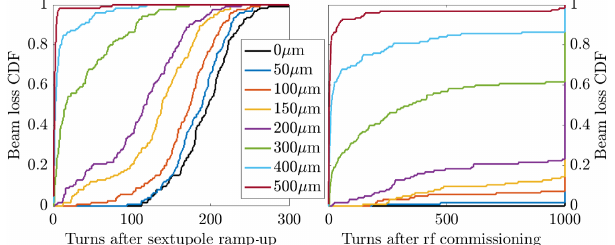
FIG. 5. Beam transmission at two stages of commissioning as described later in Secs. IVA – IV E, after ramping up the sextupole magnets (left) and after rf commissioning (right), assuming various levels of BBA accuracy for the trajectory-based BBA procedure as indicated in the inset. Each curve is the CDF of 100 lattice realizations.